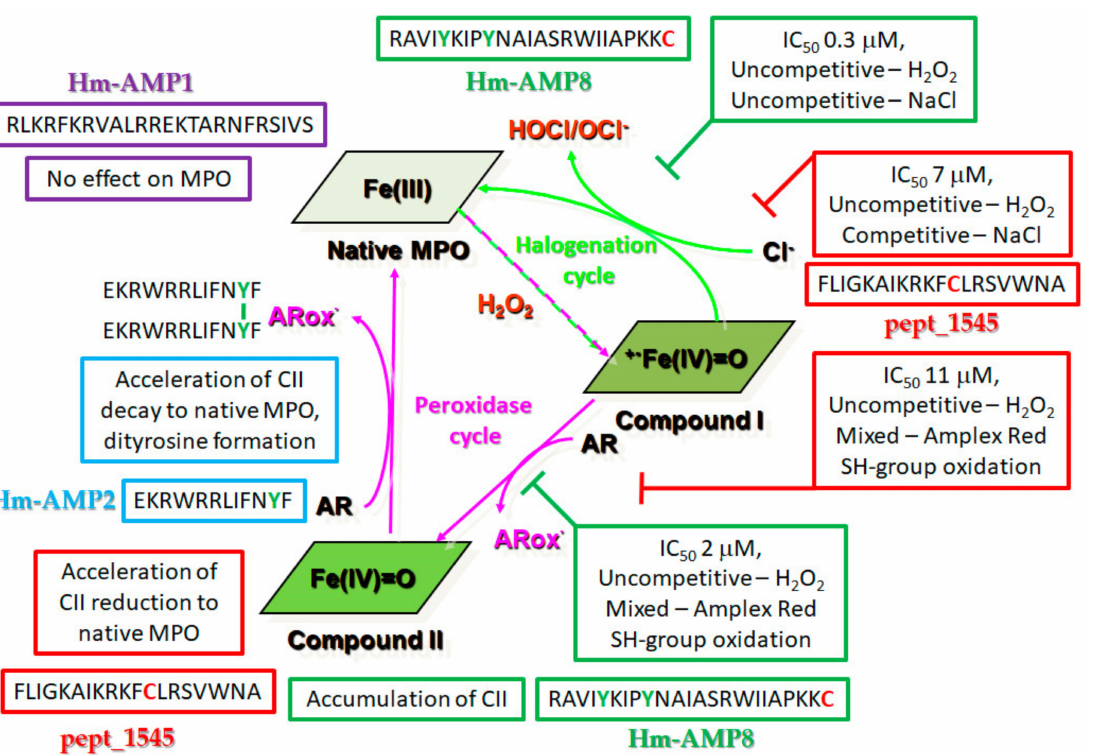
Figure 13. Proposed scheme for the effects of cationic antimicrobial peptides (CAMPs) under study on reactions of peroxidase and halogenation cycles of MPO. Native MPO existing in the ferric MPO-Fe(III) form reacts with hydrogen peroxide (H 2 O 2 ) to form the redox intermediate Compound I. Compound I either oxidizes chloride (Cl − ) to regenerate ferric MPO via the halogenation cycle (marked by green arrows) or will oxidize an organic substrate (AR) to a free radical (ARox), forming the redox intermediate Compound II, which can be reduced back to the native state via the peroxidation cycle (marked by pink arrows). Text in the box with red, green, blue, or purple border refers to pept_1545, Hm-AMP8, Hm-AMP2, and Hm-AMP1,